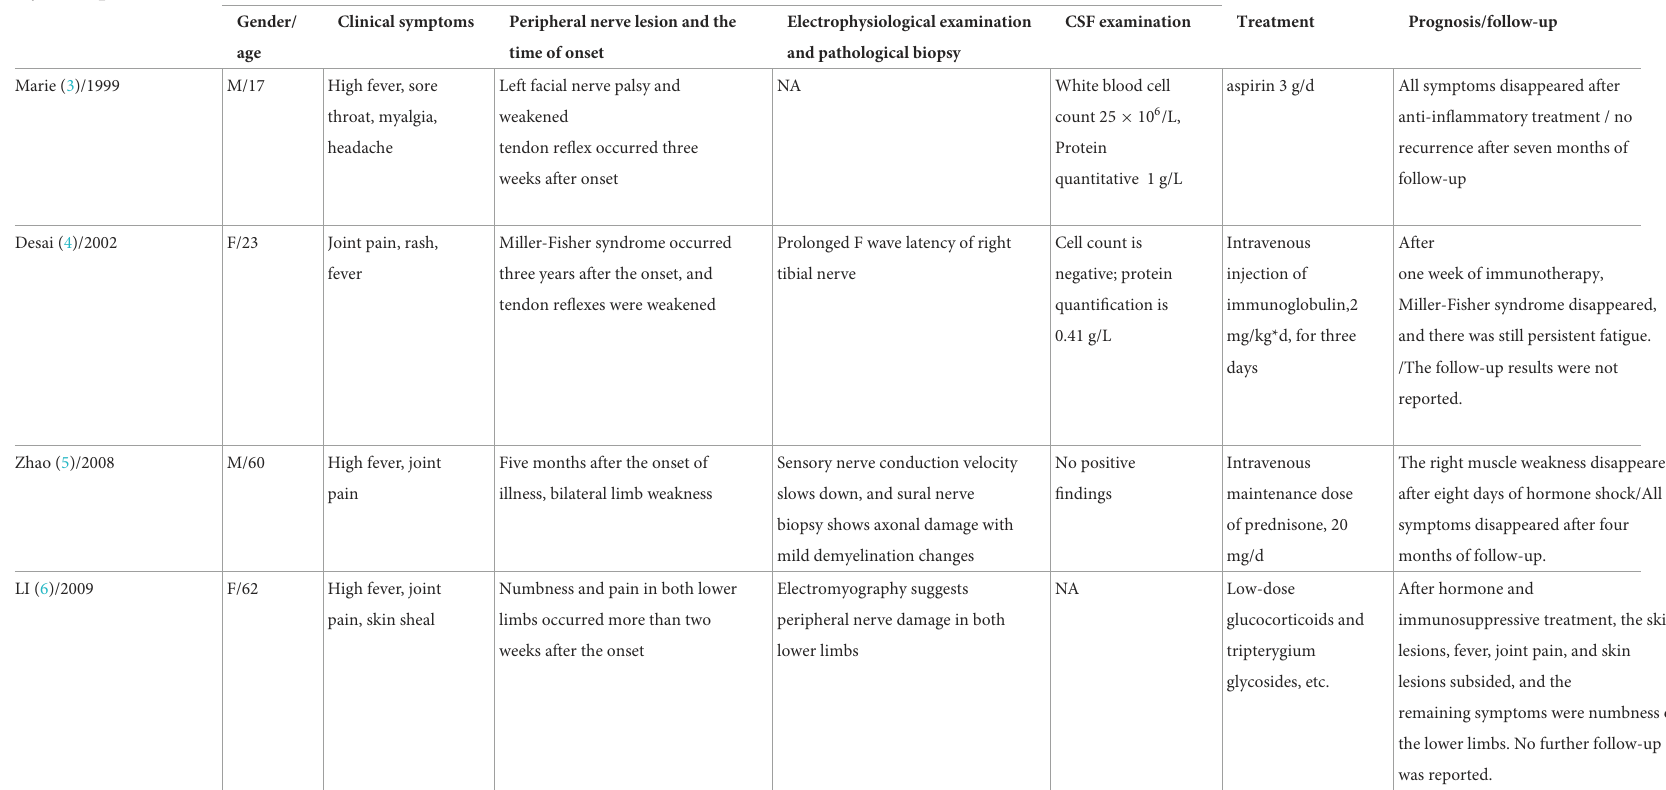
TABLE 1 Summary of literature on adult-onset Still’s disease * with peripheral nerve